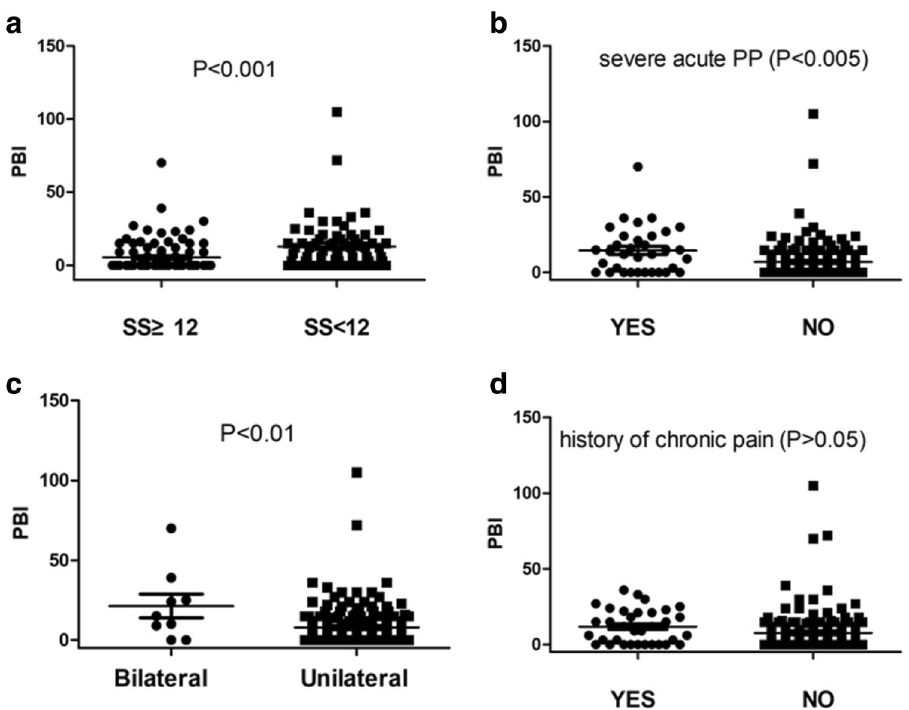
Figure 1. PBI of the patients in different subgroups. ( a ) the PBI for patients in the SS ≥ 12 group was significantly lower than that of patients in the SS < 12 group (p < 0.001); ( b ) the PBI for patients in the severe acute PP group was significantly higher than that of patients in the non-severe group (p < 0.005); ( c ) the PBI for patients receiving bilateral IBBR was significantly higher than that of patients receiving the unilateral procedure (p < 0.01); and ( d ) subgroup analysis showed that the PBI was similar for patients with or without a history of preoperative chronic pain (p >